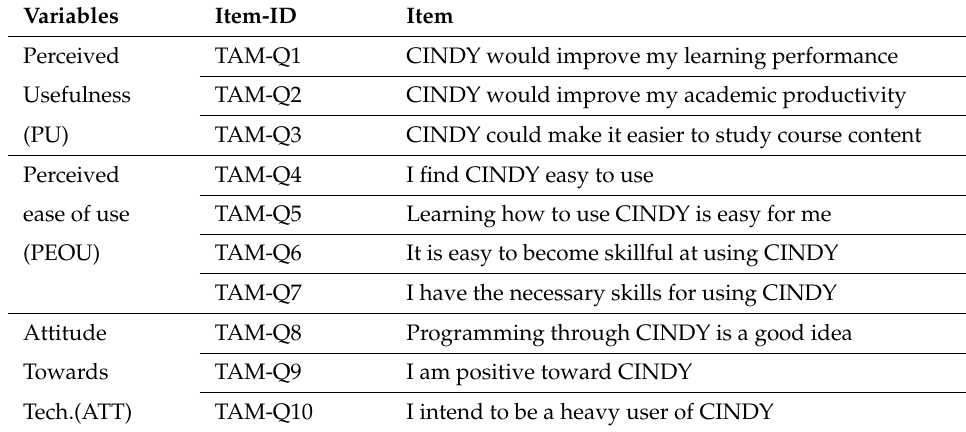
Table 1. TAM Questionnaire proposed in this study (English version).